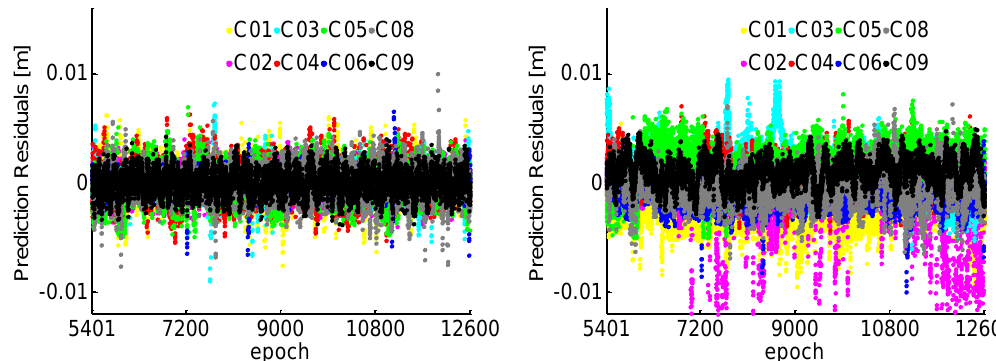
Figure 5. Ionospheric prediction residuals with 1 s interval. The left panel shows the residuals based on B1 and B2, the right panel based on B1 and B3.